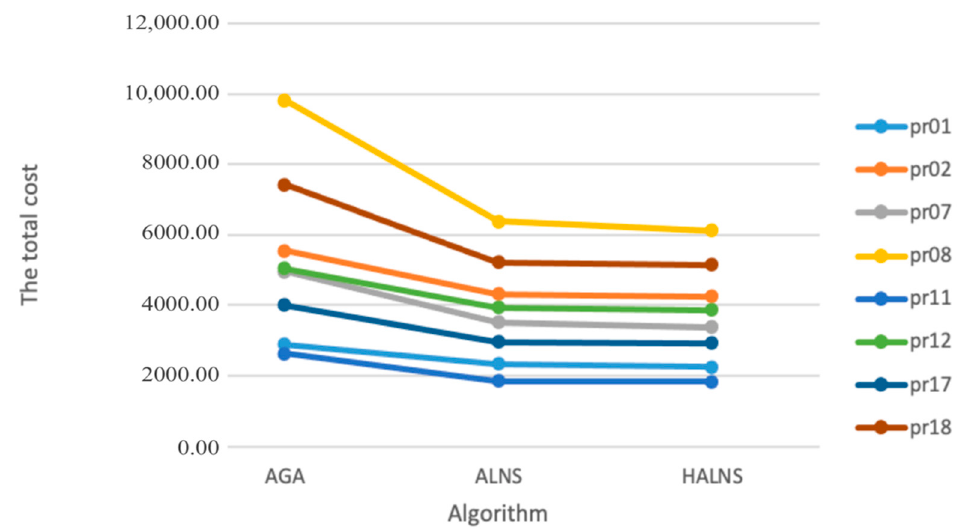
Figure 11. Comparison of experimental results with different datasets.